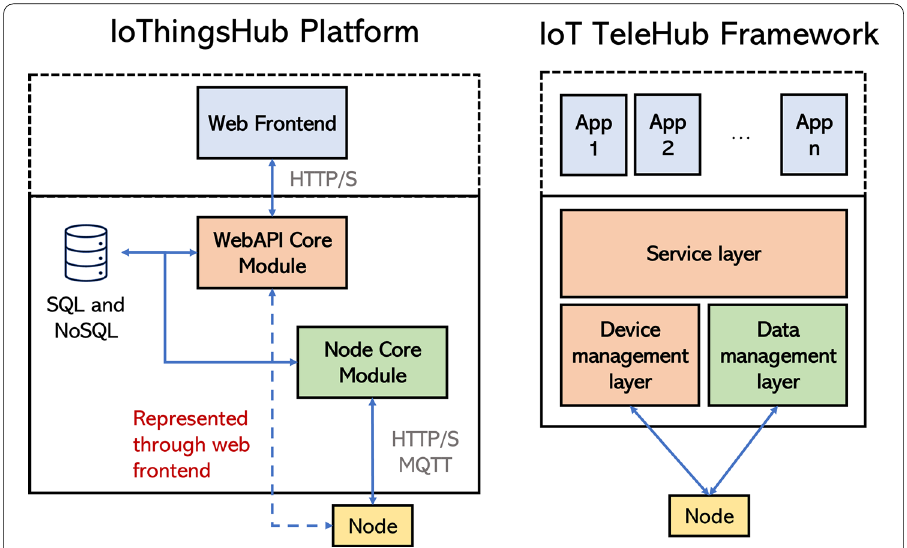
Fig. 9 IoThingsHub architecture mapping to the proposed